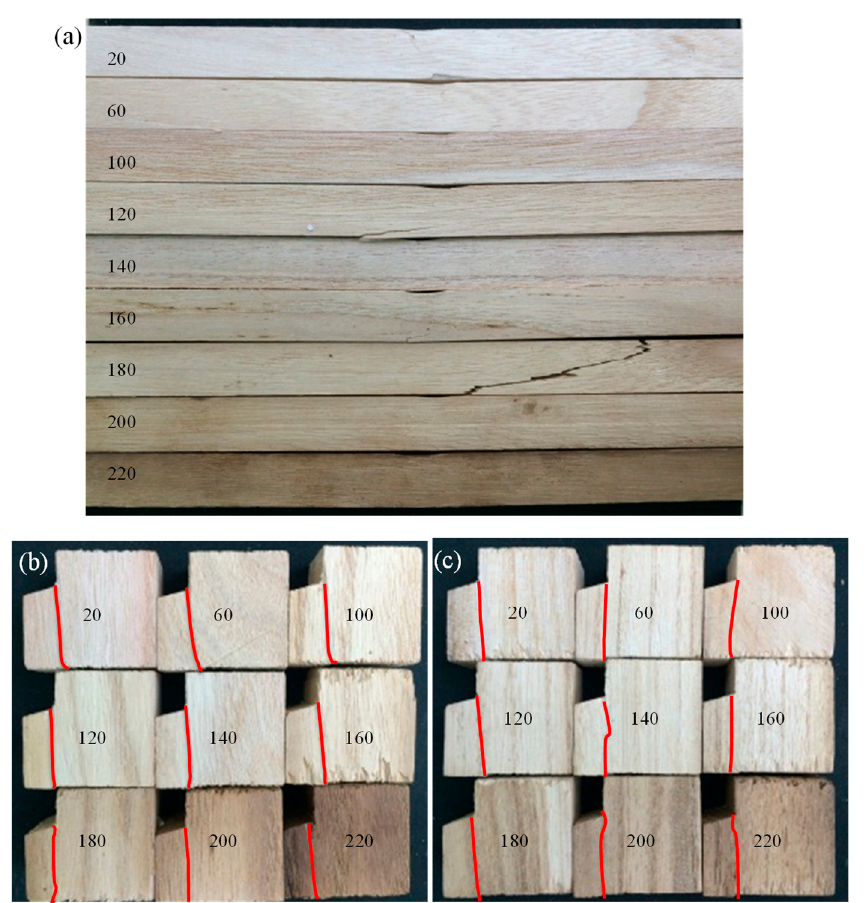
Figure 5. The moisture content dramatically reduced from 10.9% at 20 °C to 2.9% at 60 °C, then gradually decreased to approximately 0.6% at 100 °C. Moreover, the moisture con- tent was zero (the wood is totally dried) when the temperature was above 120 °C.